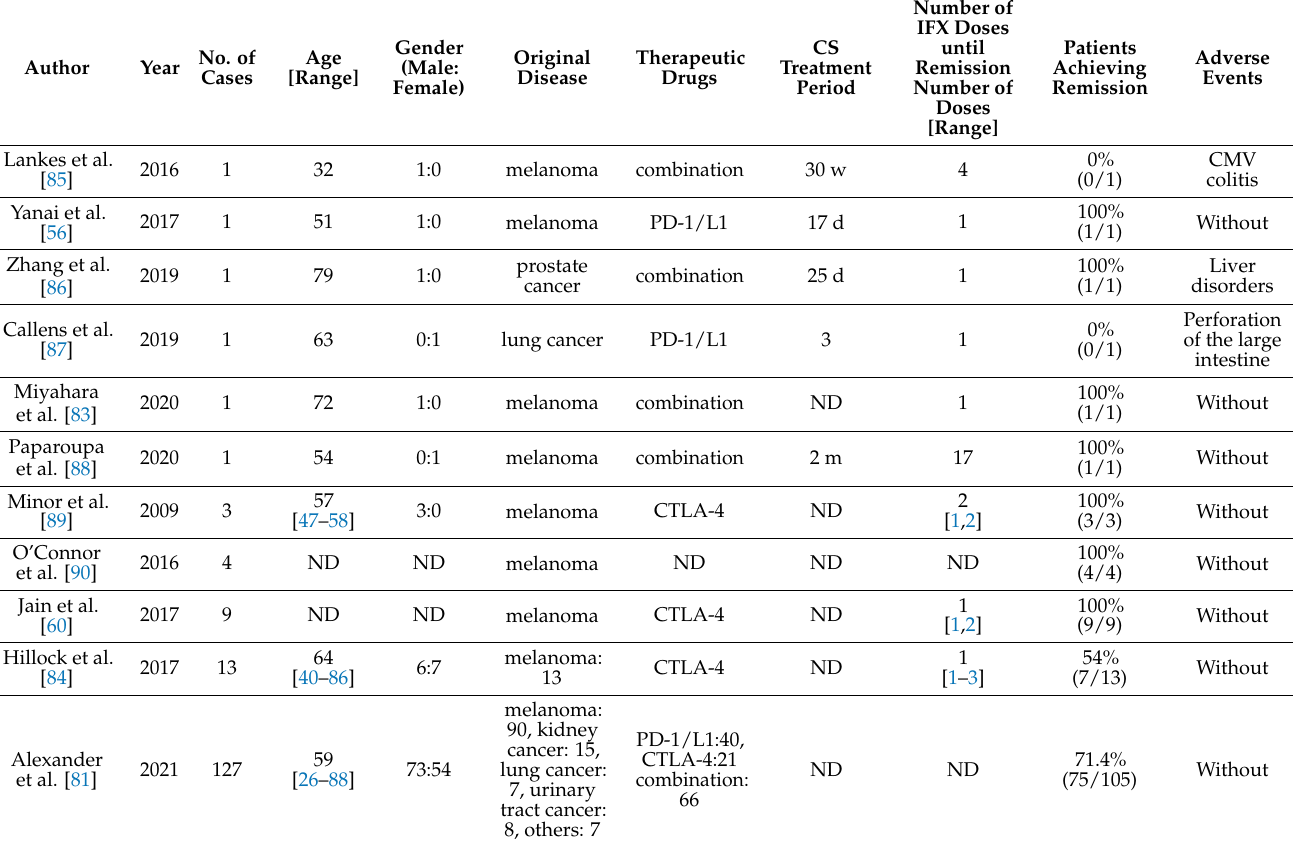
Table 3. Summary of the cases of infliximab use for irAE